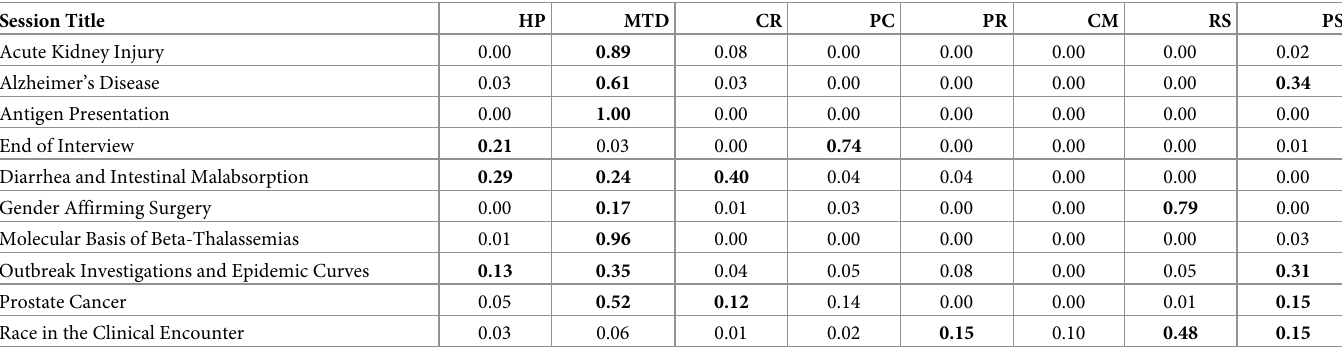
Table 2. Mapping of sessions to